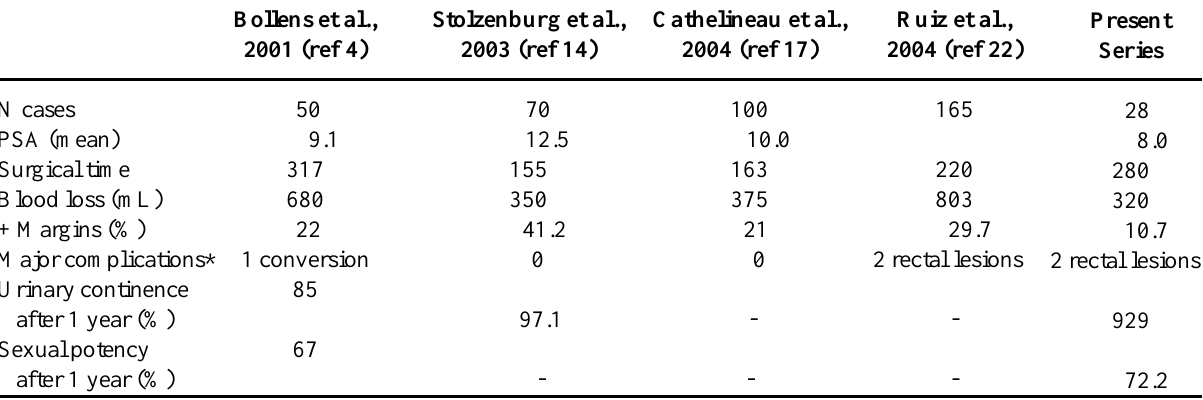
Table 3 – Data from some early series on extraperitoneal endoscopic radical